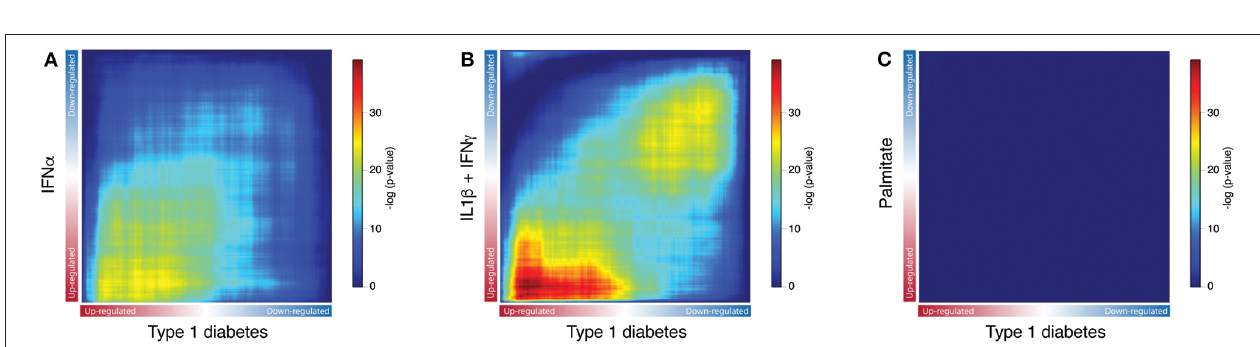
FIGURE 2 | Correlation between the transcripts expressed in human islets exposed to IL1 β + IFN γ , IFN α or palmitate and the transcripts expressed in human beta cells of individuals affected by T1D. Data were obtained by RNA sequencing ( 10, 12–14). The Pearson correlation (1 – correlation) was used to evaluate the (dis)similarities (distance) among the 300 most variable transcripts in the RNA-seq datasets. Red squares represent a positive correlation (similarity), blue squares a negative correlation (dissimilarity) and white squares an absence of correlation between each pair of observations. Next, the hierarchical clustering was performed considering the average of the dissimilarity (distance) between samples. The resulting dendrogram is shown in the upper and lateral part of the matrix.